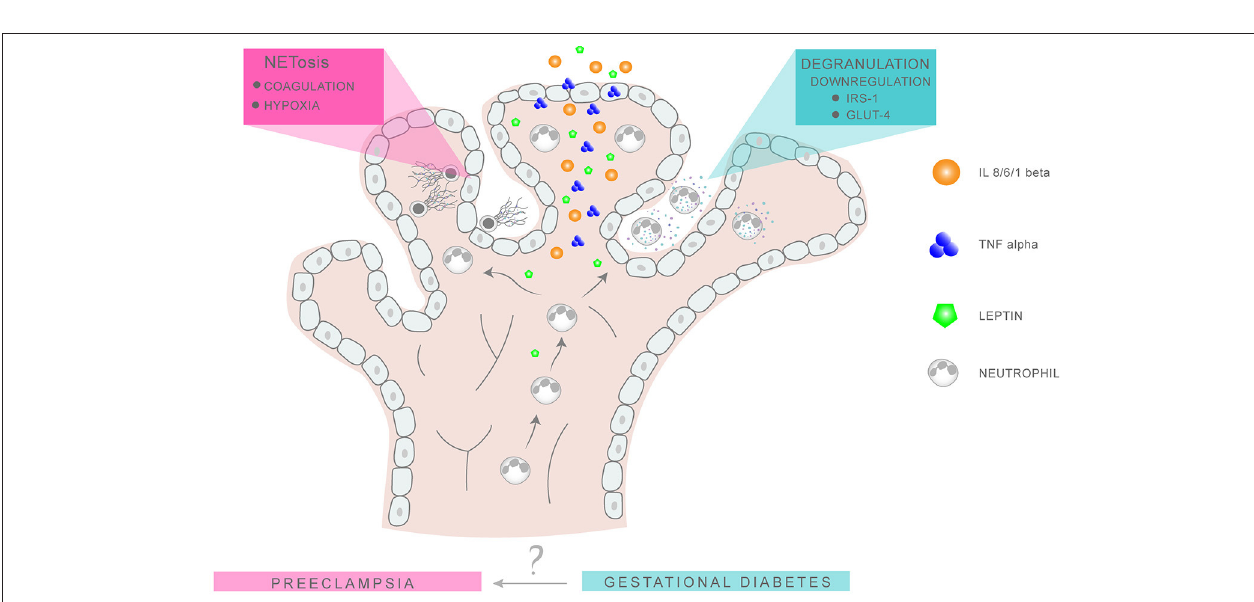
FIGURE 2 | Putative neutrophil activity in GDM and PE placentae. Neutrophil migration into the intervillous space is favored by the chemokine action of leptin, IL-8, and TNF α . In GDM, the release of NE via degranulation results in the degradation of IRS1 and GLUT4 in surrounding tissues, leading to an imbalance in glucose metabolism and insulin response. In PE, excessive NETs formation promotes placental occlusion and hypoxia, leading to extensive tissue damage.